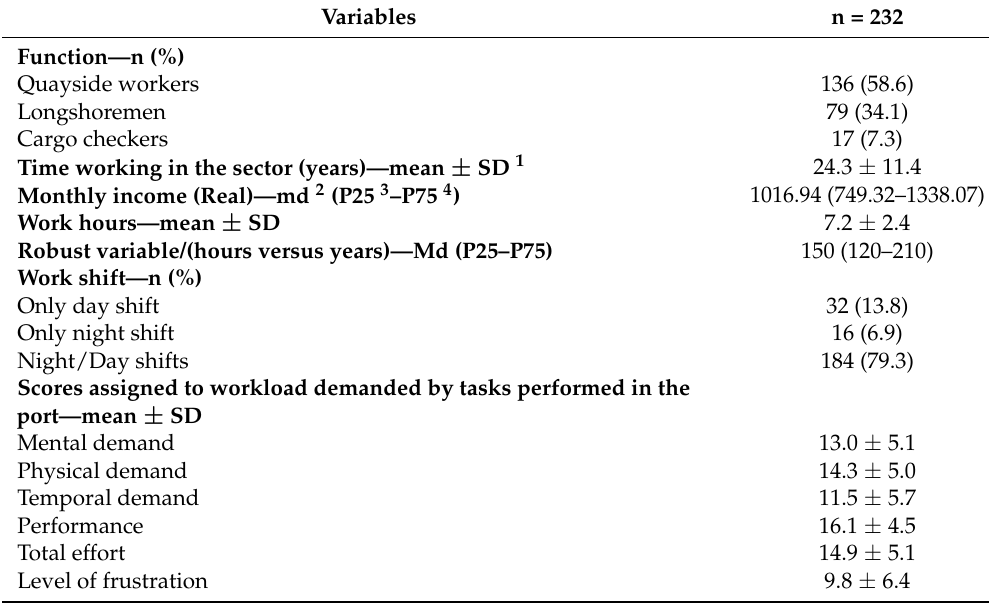
Table 2. Work data (n = 232).